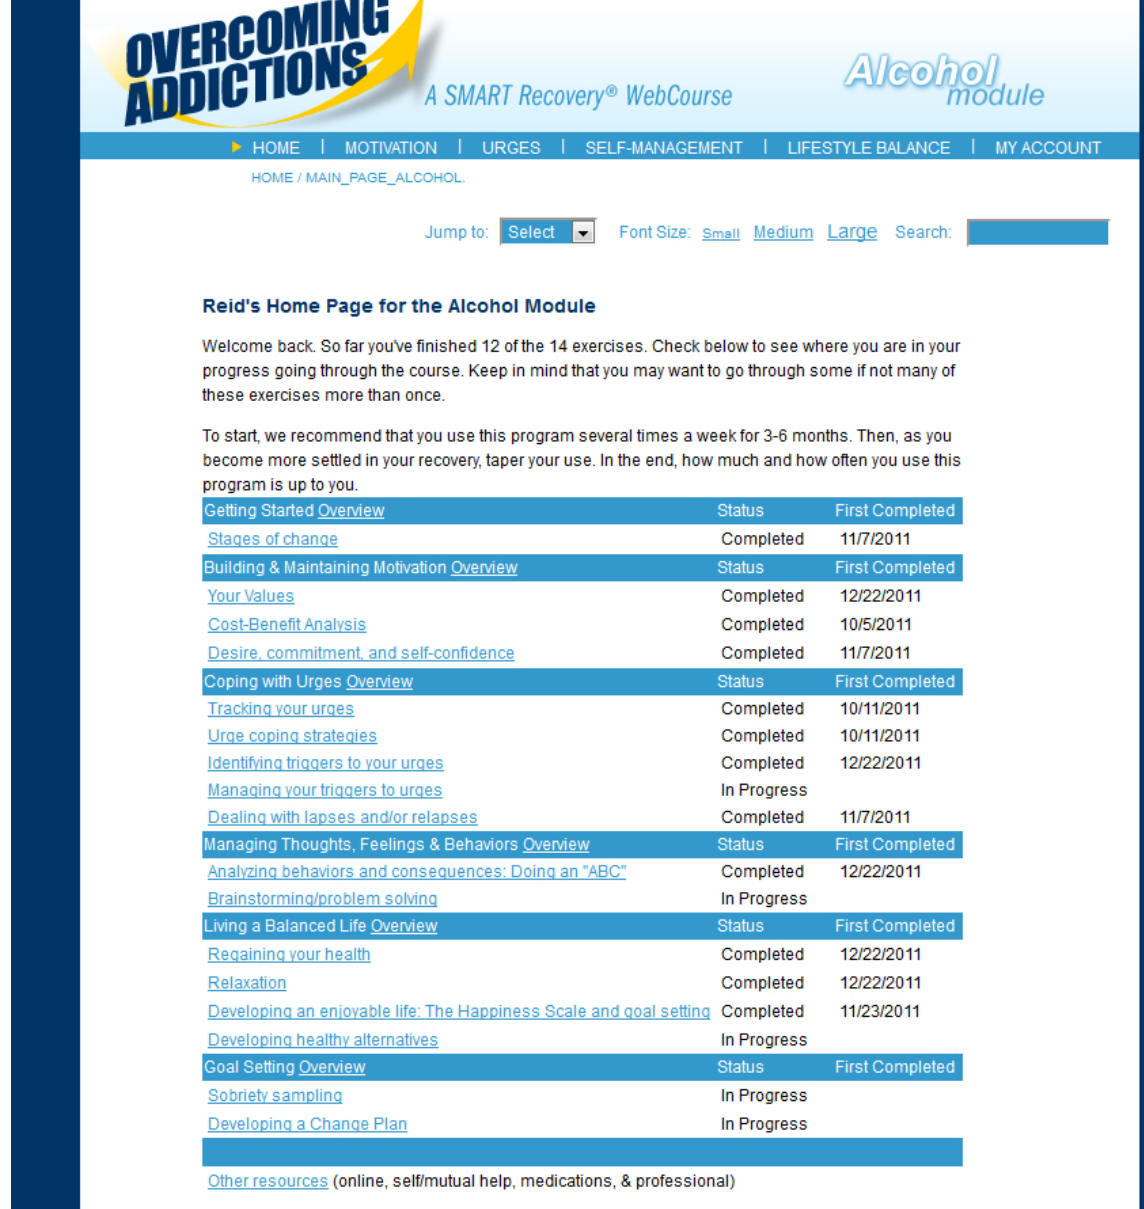
Figure 1. Overcoming Addictions Web app home